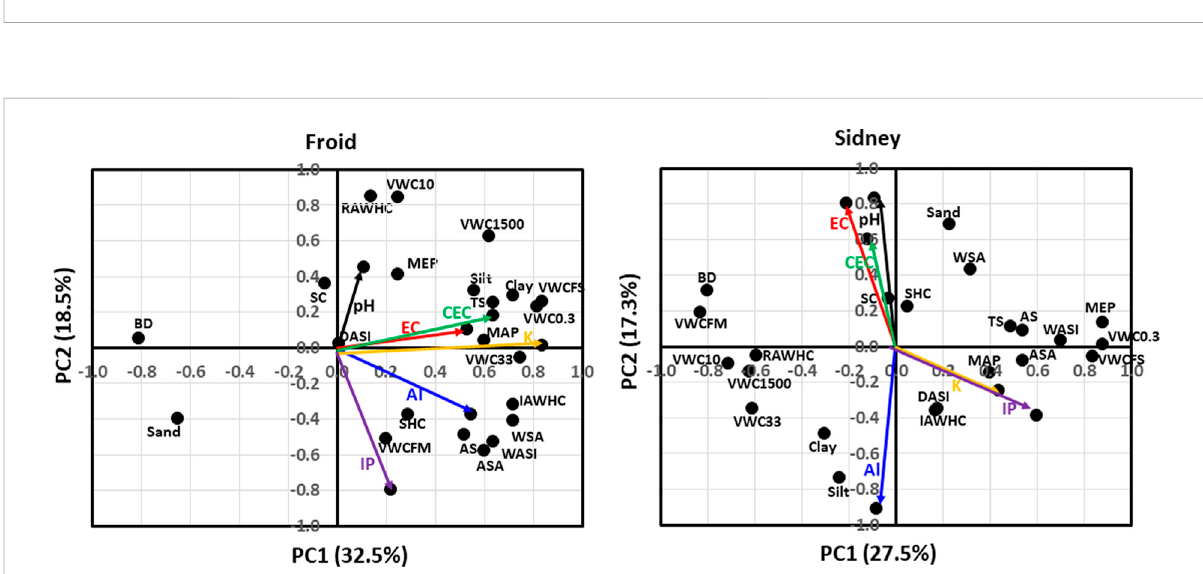
FIGURE 2 Principal component analysis for associations among soil pH, electrical conductivity (EC), cation exchange capacity (CEC), inorganic P (IP), K, and Al concentrations with soil physical properties at Froid and Sidney, Montana, United States. At Froid, soil properties explained 32.5% of the total variationinthe fi rstprincipalcomponent(PC1)and18.5%inthesecondprincipalcomponent(PC2).AtSidney,soilpropertiesexplained27.5%oftotal variation inPC1and17.3%ofthetotalvariabilityinPC2.ASdenotesaggregatestability;ASA,averageslakeaggregate;BD,bulkdensity;DASI,dry aggregate stability index; IAWHC, intact core available water capacity; MAP, macro-porosity; MEP, meso-porosity; RAWHC, repacked core available water capacity; SC, stone content; SHC, saturated hydraulic conductivity; TS, total shrinkage; VWC0.3, volumetric water content at 0.3 kPa; VWC10, volumetric water content at 10 kPa; VWC33, volumetric water content at 33 kPa; VWC1500, volumetric water content at 1500 kPa; VWCFM, volumetricwatercontentinthe fi